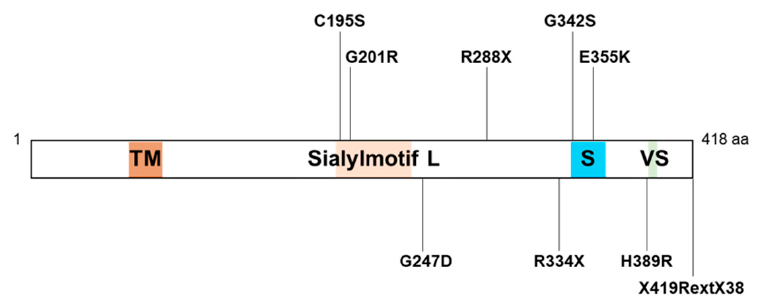
Figure 2. Sialyl motifs of ST3GAL5 and its variants detected in GM3S-deficiency patients (schematic) (see Section 4). Sialylmotifs L (large), S (small) and VS (very small) are highly conserved in mammalian sialyltransferases. X419RextX38 is a variant in the stop codon at the position 419, changing it to an R (arginine)-codon and adding a new amino acid extension with a new stop codon at position 38. TM, transmembrane domain.